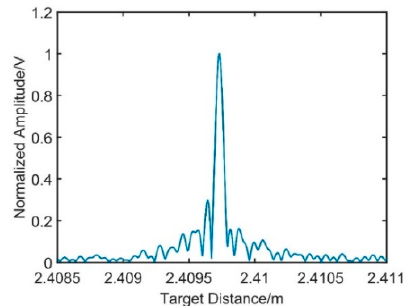
Figure 9. Dispersion compensation based on resampling of the modulated signal.